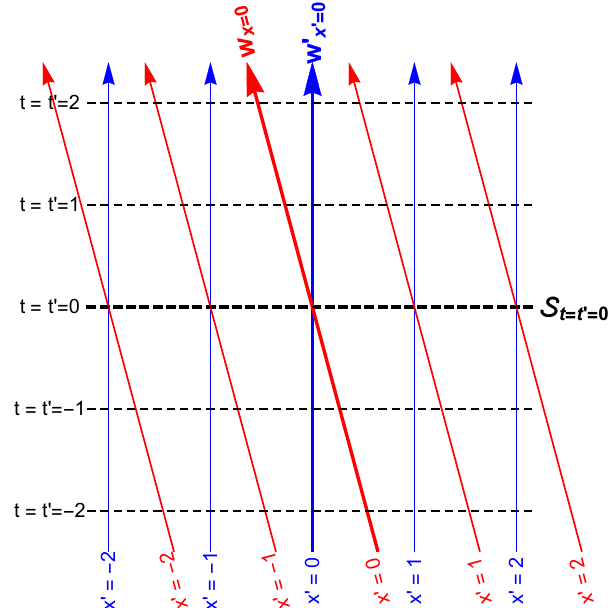
Figure 4. Galilei/Newton spacetime G as charted in time coordinate t (cid:48) and position space coordinate x (cid:48) (other position space dimensions suppressed) by an inertial reference frame (cid:79) (cid:48) (observer worldlines, blue), showing also (cid:79) (observer worldlines, red) moving with negative velocity in the x (cid:48) direction relative to (cid:79) (cid:48) . This figure is a Galilei boost or ‘beveling’ of Figure 3, under which the absolute hyperplanes of simultaneity remain